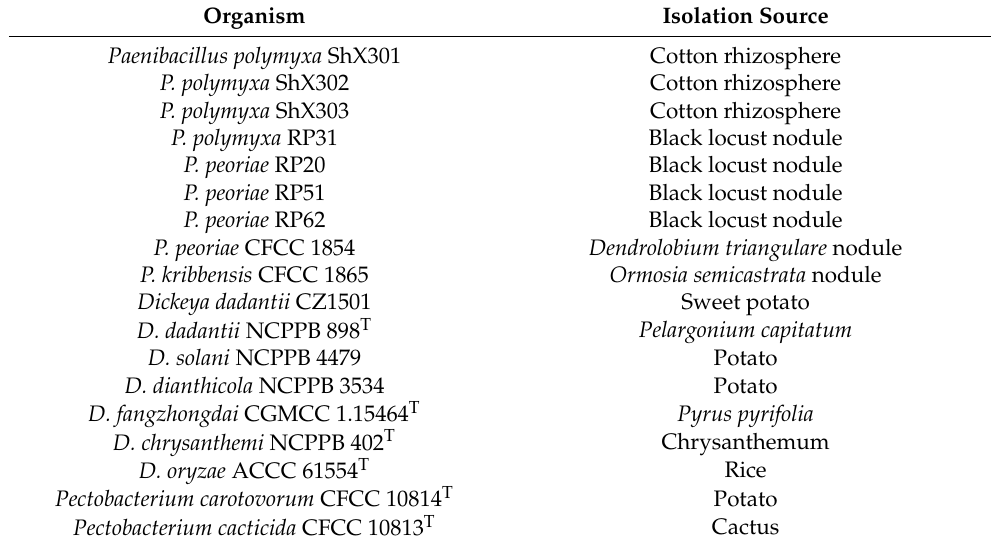
Table 1. Bacterial strains used in this